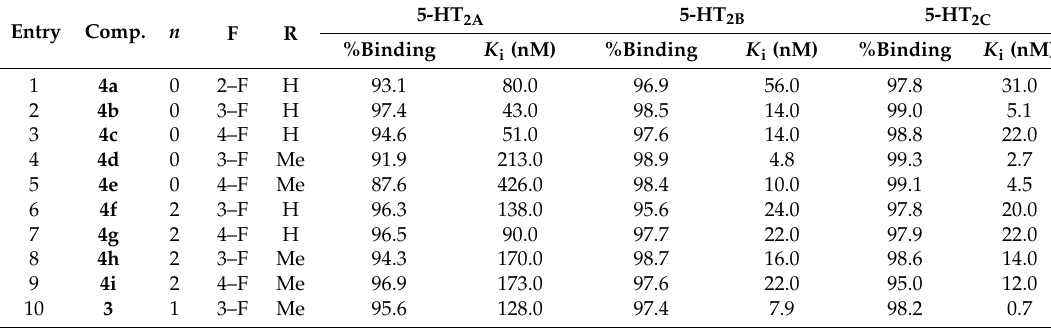
Table 1. Binding affinities of pyrimidine analogues 4a – i against 5-HT 2 receptor